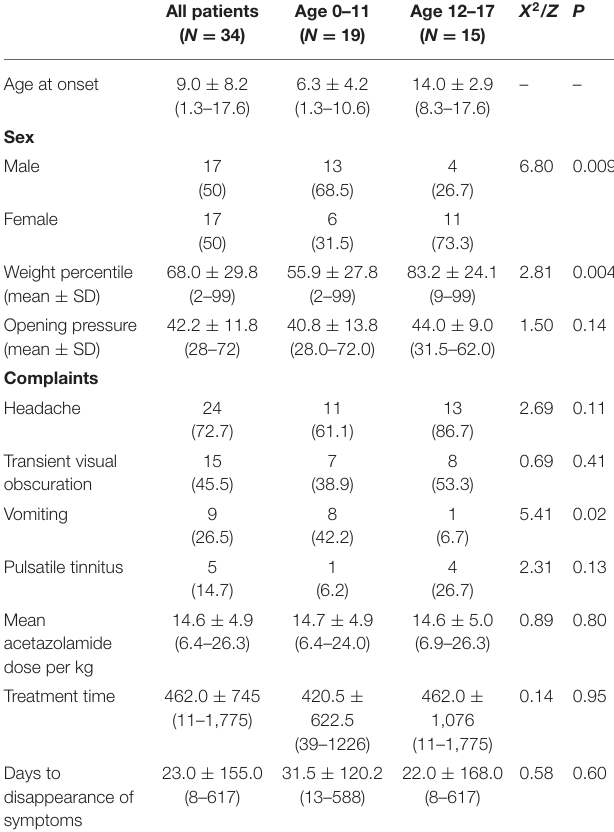
TABLE 1 | Demographic and clinical characteristics of patients with PTCS distributed by